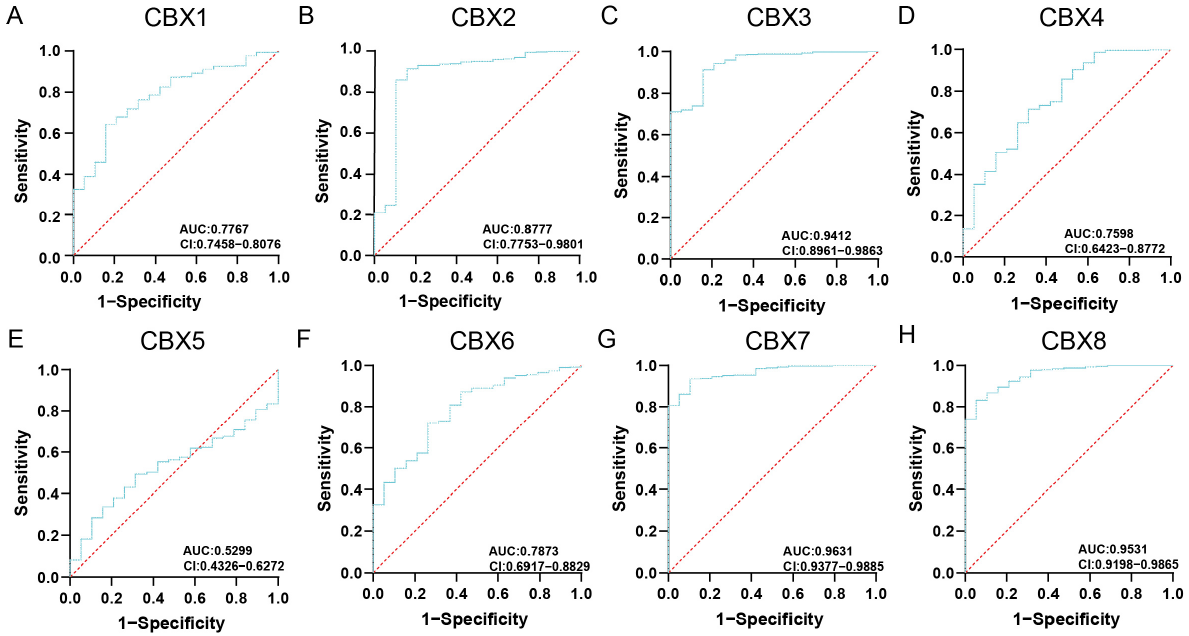
Figure 3. Receiver operating characteristic (ROC) curves for each CBX gene in BLCA. ( A ) CBX1; ( B ) CBX2; ( C ) CBX3; ( D ) CBX4; ( E ) CBX5; ( F ) CBX6; ( G ) CBX7; ( H ) CBX8. CI, confidence interval; AUC, area under the curve.